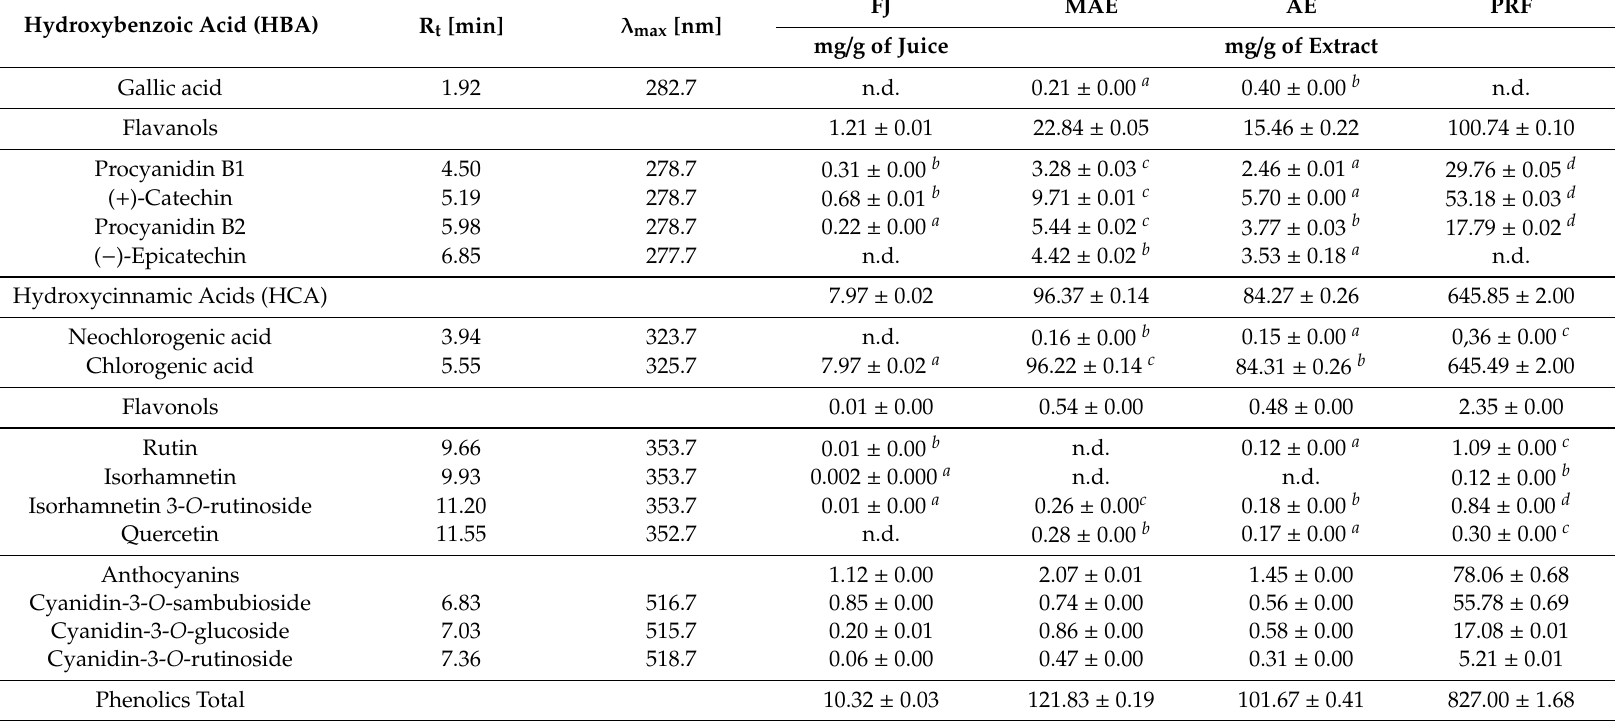
Table 1. Individual phenolic compounds content in Viburnum opulus